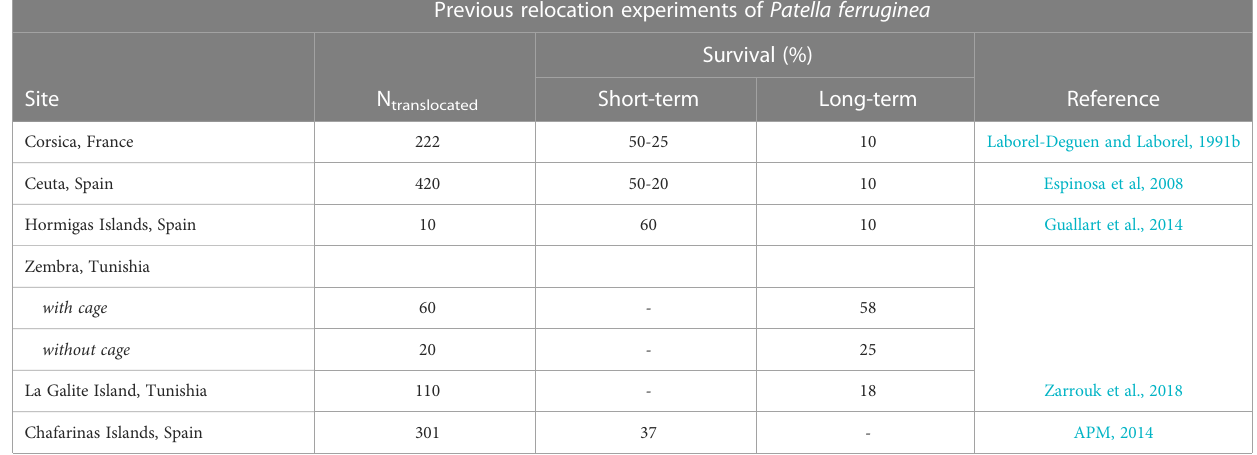
TABLE 4 Main data recollected from previous direct and individual removals of specimens of Patella ferruginea which proved to be unsuccessful. Previous relocation experiments of Patella